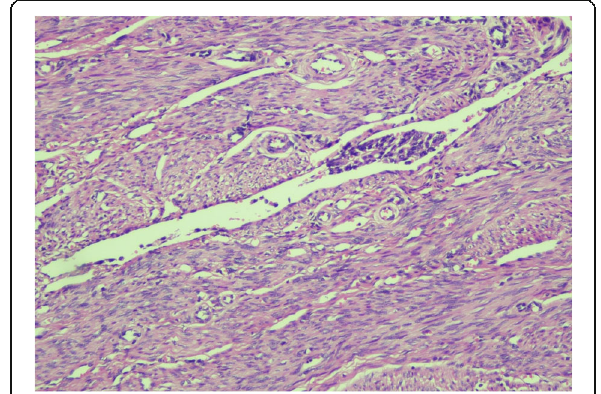
Fig. 1 Focal lymphovascular invasion is defined as ‘ the presence of